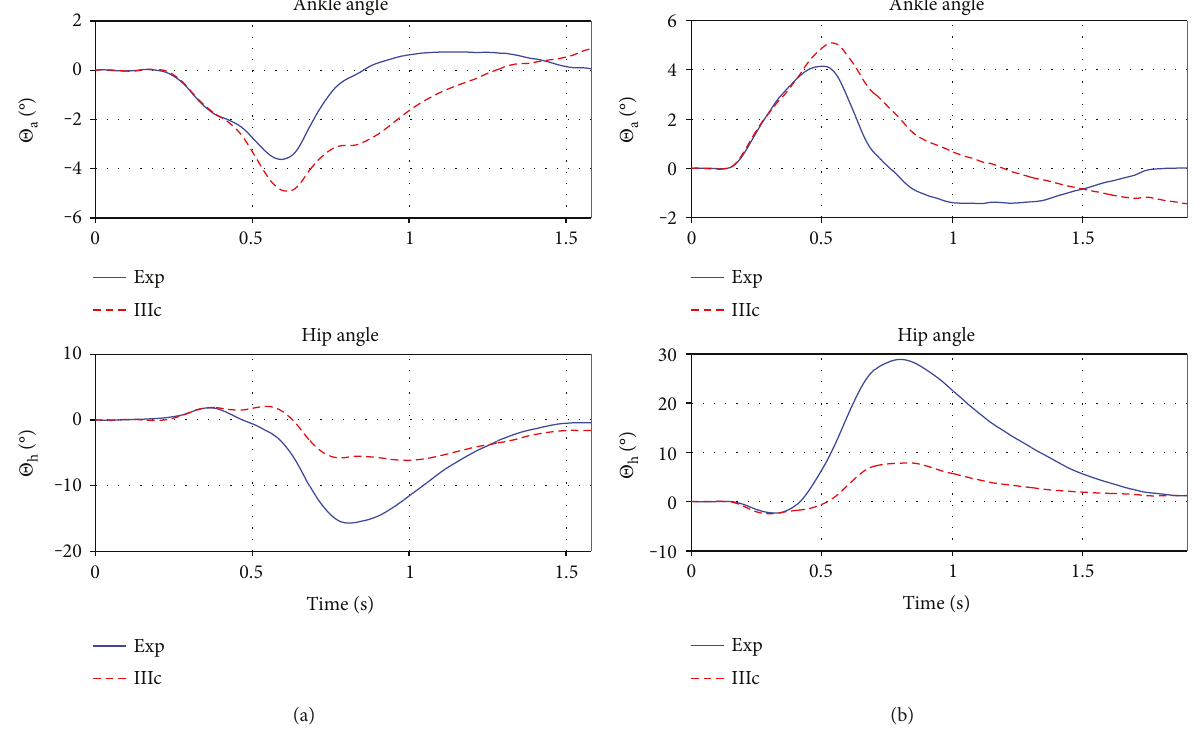
Figure 11: Best (a) and worst (b) prediction for participant (4). Plotted are the ankle and hip angle in deg. over time in seconds. The red/ dashed lines are the experimental trials, and the blue/solid lines are the corresponding simulation of controller IIIc . Without avrg considering participant (4) in fi nding the control parameters X , the controller is able to predict his trials, however with a considerable amount of under and overestimation, but not to that point where qualitative change in behavior or instability is observed. Table 3: Participant speci fi c ratios β